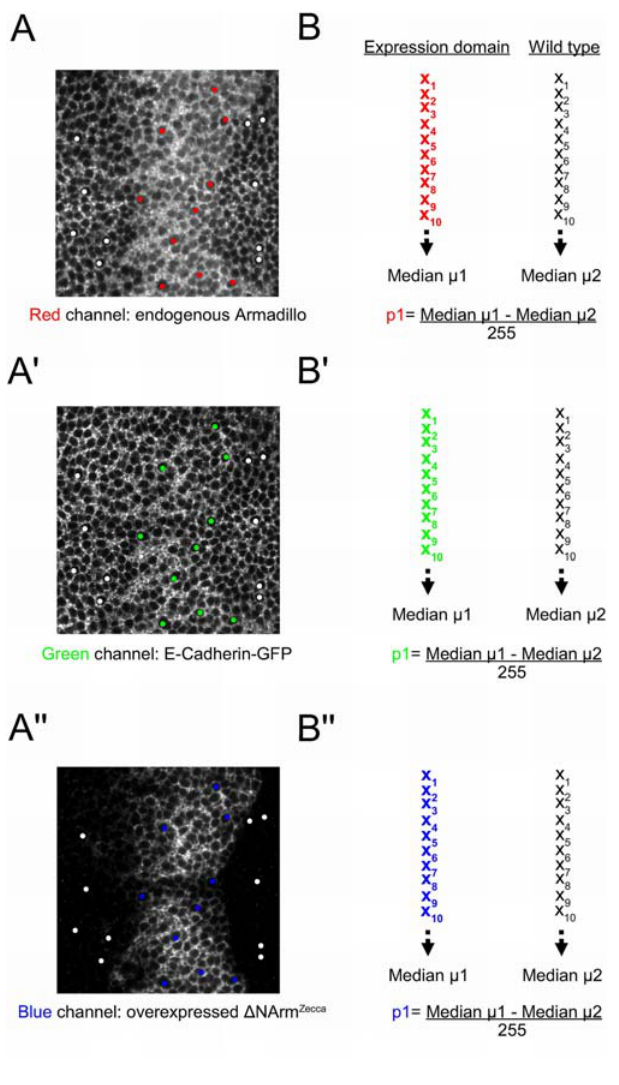
Figure 3. Example illustrating the quantification method developed to compare changes in Armadillo protein levels in the nucleus across experiments. (A, A 9 , A 0 ) UAS Myr- D NArm 1–155 is overexpressed in the dppGAL4 domain, which drives expression in a stripe at the A/P boundary. Red, green, and blue channels; representing (A) endogenous Armadillo, (A 9 ) E-Cadherin-GFP under a ubiquitous promoter, and (A 0 ) Myr- D NArm 1–155 , respectively; are assessed sepa- rately from the same confocal section, here through the cytoplasm approximately 10% below the AJ (60 6 2 magnification). The red, green and blue spots represent the 10 data points selected from which to calculate median levels within the domain of expression (B, B 9 , B 0 ). The white spots highlight the data points outside the domain of expression used to remove ‘‘background noise’’, as the nuclei are expected to have zero pixel intensity here. Thus for each channel, p1 is calculated as m 2 subtracted from m 1, and normalised to a maximal pixel intensity of 255. doi:10.1371/journal.pone.0002893.g003 More basally (10–50%; 10% shown), the distributions of apicobasal polarity markers did not differ appreciably upon overexpression of Arm S10 compared to Wingless (not shown).